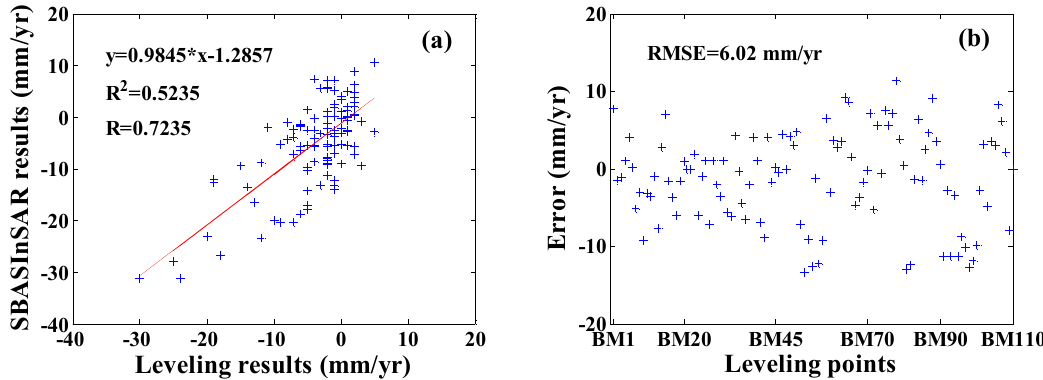
Figure 7. ( a ) Regression analysis between surface vertical deformation rates derived by SBAS InSAR and leveling; and ( b ) differences between SBAS InSAR- and leveling-derived results. Table 2. Comparison of average subsidence rates between SBAS InSAR- and leveling-derived results. Mean error is the mean of the differences between SBAS InSAR- and leveling-derived rates. RMSE represents the standard deviation of the differences between SBAS InSAR- and leveling-derived rates (unit: mm/year).